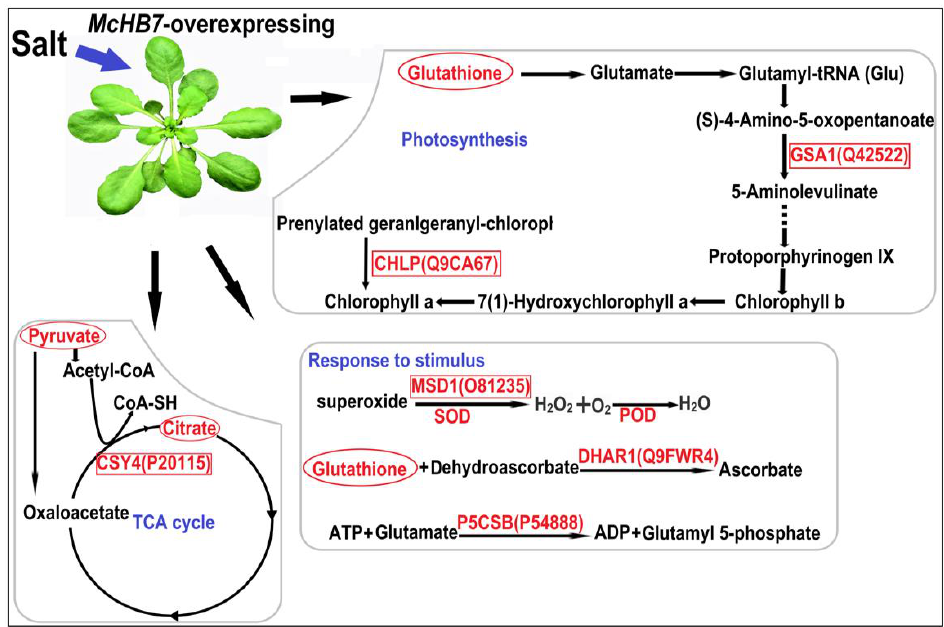
Figure 6. Schematic representation of Mc HB7 functions in salt response of the OE Arabidopsis. The words in red represent an increase in the OE plants under salt stress. The words enclosed in a square and oval represent increased proteins and metabolites, respectively. SOD (superoxide dismutase) and POD (peroxidase) activities increased in the OE plants after salt stress treatment.